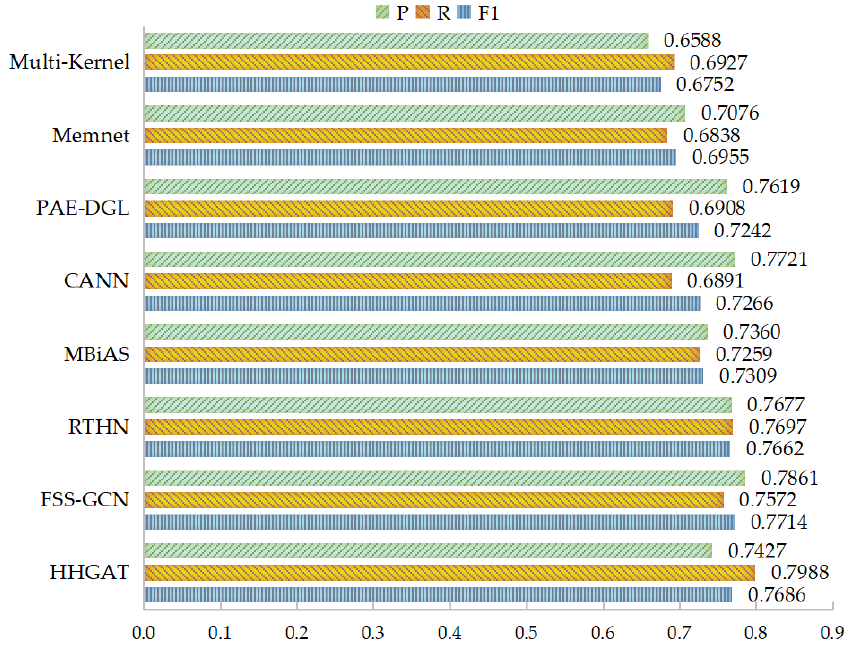
Figure 3. Comparison of experimental results on ECE.